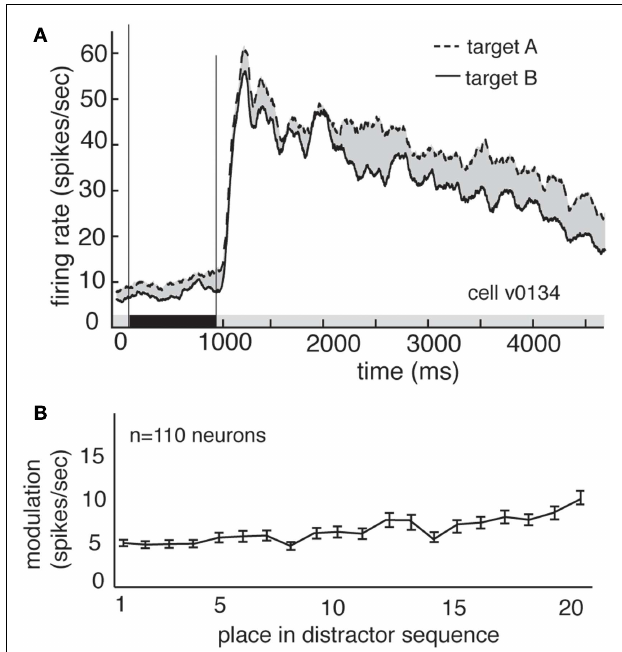
FIGURE 3 | Delay modulation persists across distractors. (A) Average responses of the same neuron shown in Figure 2 during cue, delay, and distractor periods of the task. Delay modulation persists into distractor period and continues throughout distractor period for this neuron. Black bar below graph indicates delay period. (B) Size of modulation at each position in the distractor sequence, averaged over all trials and neurons. Bars indicate one standard error. Modulation is not abolished, even after 20